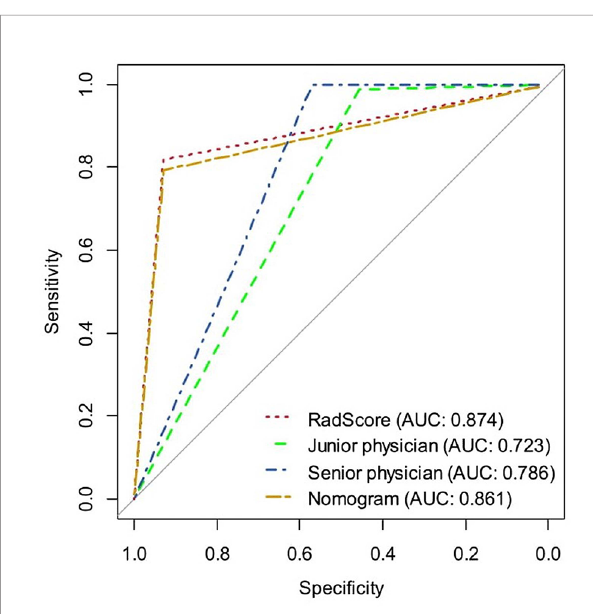
FIGURE 5 | The ROC curves of the radiomics signature, radiomics nomogram, senior physician, and junior physician in the validation set, respectively.